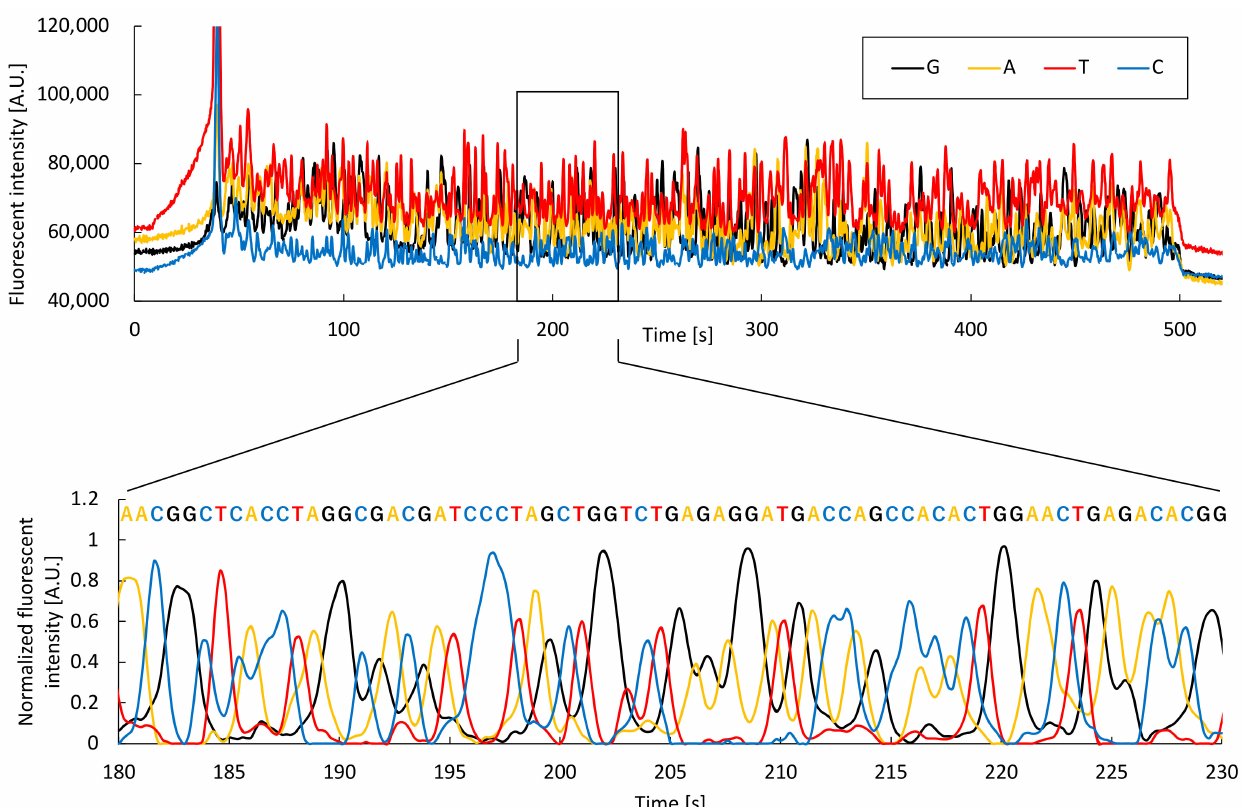
Figure 7. Electrophoresis data for E. coli and an enlarged view of the analysis based on the developed algorithm.